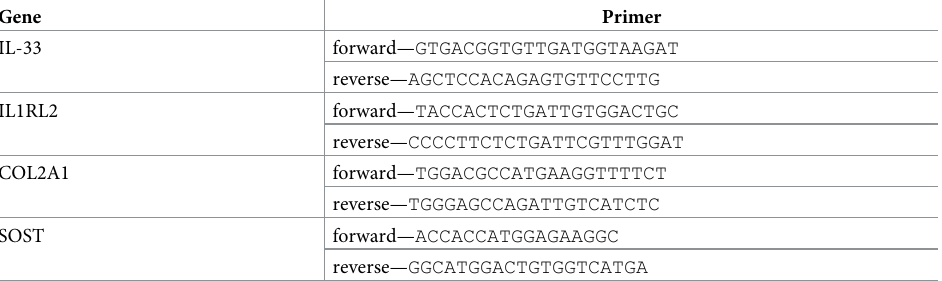
Table 1. Genes validated using qPCR with their respective